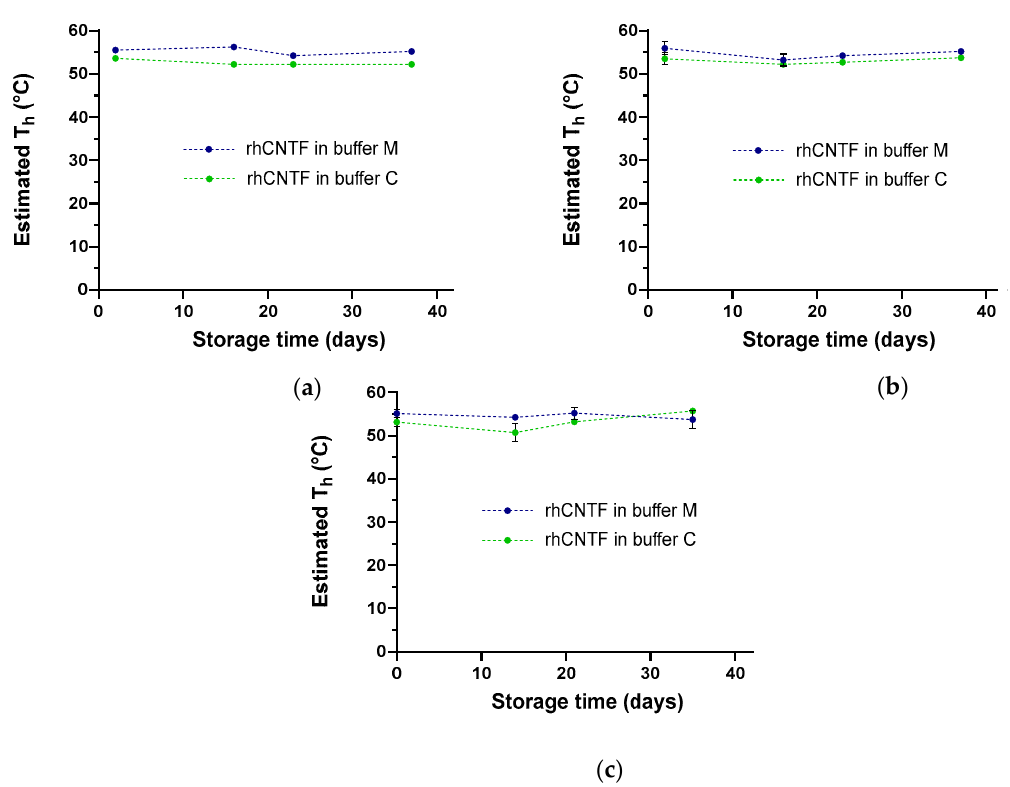
Figure 4. T h estimation of rhCNTF during storage ( a ) on ice at 4 °C, ( b ) − 80 °C, and ( c ) on ice at 4 °C post-thawing.